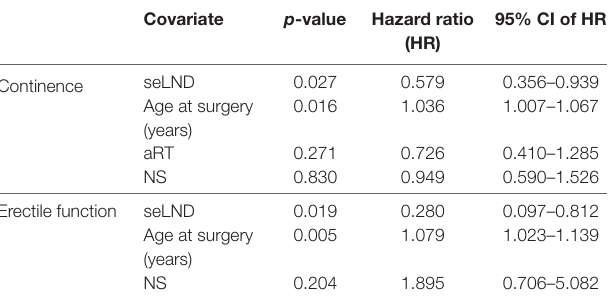
TaBle 2 | Multivariate analyses for continence and erectile function using Cox proportional-hazards regression.